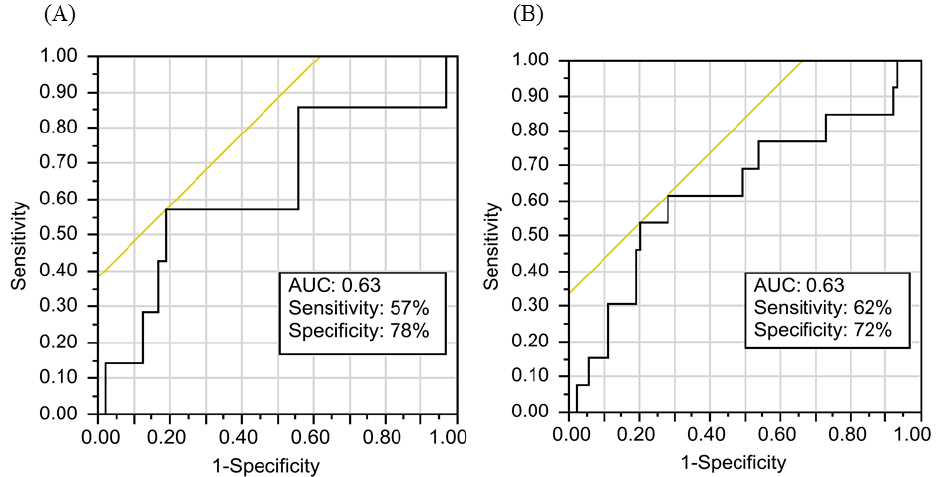
6 of 13 Figure 2. Kaplan – Meier curve depicting overall survival ( A ) and disease-free survival ( B ). 3.3. Optimal NLR Cutoff In the ROC analysis for the NLR cutoff value, the area under the curve (AUC) was 0.63 ( p = 0.001) for OS, and an NLR of 3.3 exhibited a maximal sensitivity level of 57% and